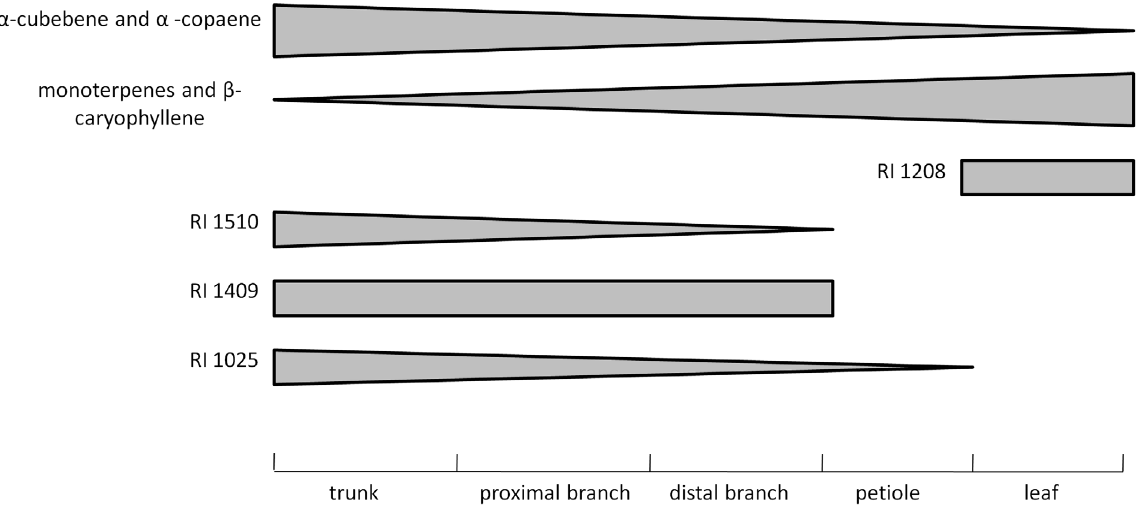
Figure 2. Schematic illustration of the distribution of selected chemicals according to their relative proportions. RI=Retention Index. Trunks were sampled at 60 cm height; proximal and distal branches correspond to 3.8 and 0.5 cm diameter respectively.